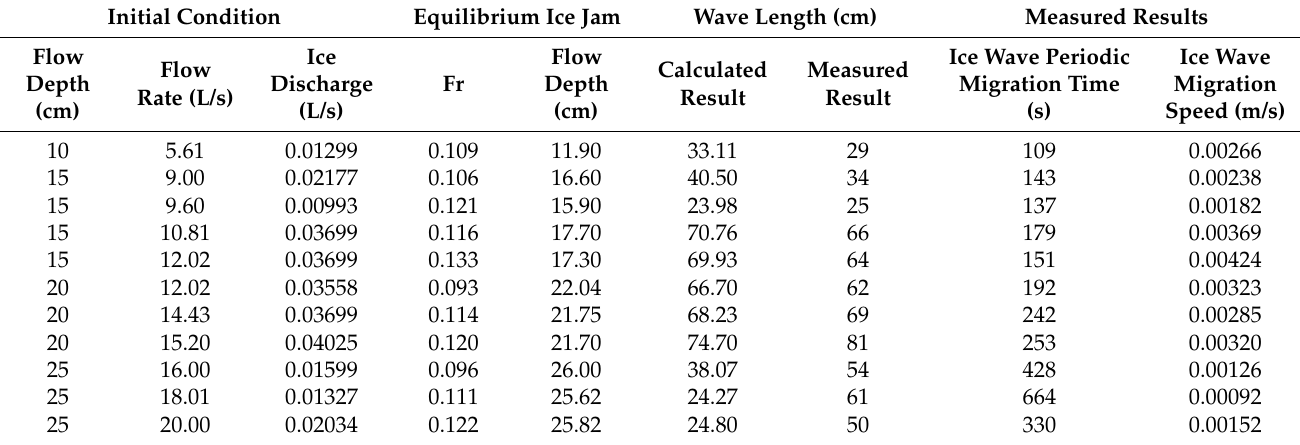
Table 4. Calculated ice wavelength compared to those of laboratory experiments and measured speed of ice wave